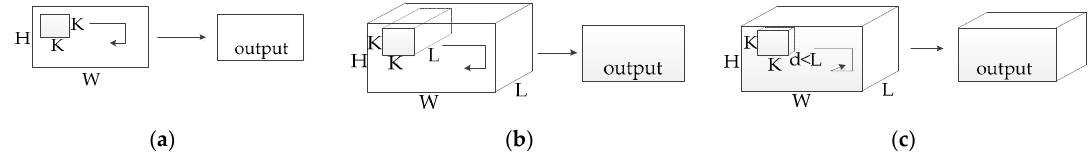
Figure 4. Diagram of convolution process [32]: ( a ) 2-D convolution; ( b ) 2-D convolution on multiple frames; ( c ) 3-D convolution.